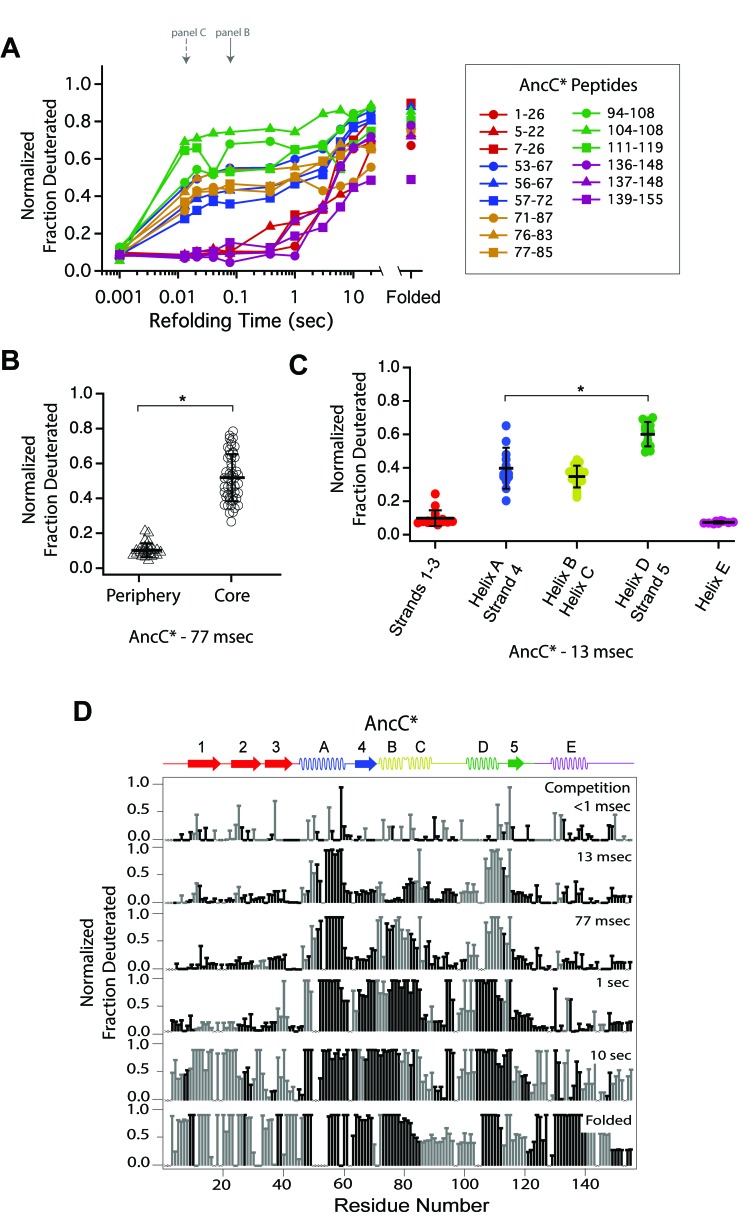
Determination of the folding pathway of AncC* by HX-MS.(A) Protection of representative peptides from AncC* at various refolding times. Peptides are colored according to their corresponding structural element. The solid arrow indicates the refolding time point analyzed in panel B. The dotted arrow indicates the refolding time point analyzed in panel C. (B) Protection of peptides mapping to the core region (Icore) or the periphery region of AncC* at 77 msec after refolding. Bars represent the mean and standard deviation of each data set. *p<0.0001 (Welch’s unpaired T-test) (C) Protection of peptides of AncC* mapping to distinct secondary structural elements at 13 msec after refolding. Bars represent the mean and standard deviation of each data set. *p<0.0001 (Welch’s unpaired T-test). Data for B and C represent aggregate data from three separate experiments. (D) Residue-resolved folding pathway of AncC* at representative refolding time points. Data points in black indicate residues that are site-resolved. Data points in grey indicate residues in regions with less peptide coverage and are thus not site-resolved with the neighboring residues. Residues where site-resolved protection could not be determined due to insufficient peptide coverage is denoted with a ‘x’.